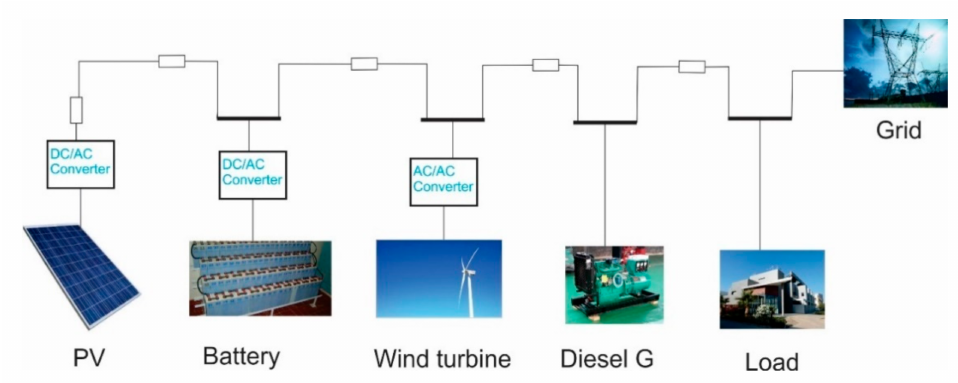
Figure 6. Scheme of the microgrid test used for the experiments.